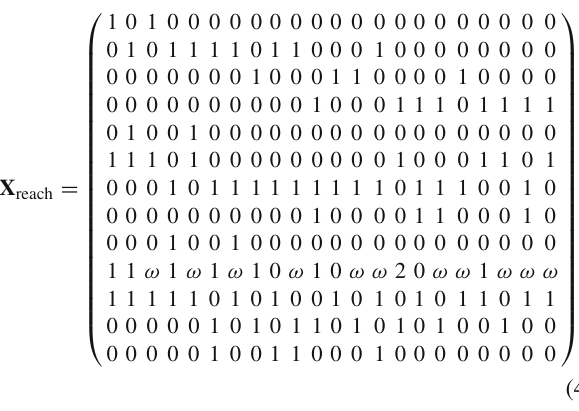
ing, p 2 = being before the crossing, p 3 = being within the crossing, p 4 = being after the crossing; (ii) the barrier of the crossing gate has the states: p 11 = it is up, p 12 = it is down.